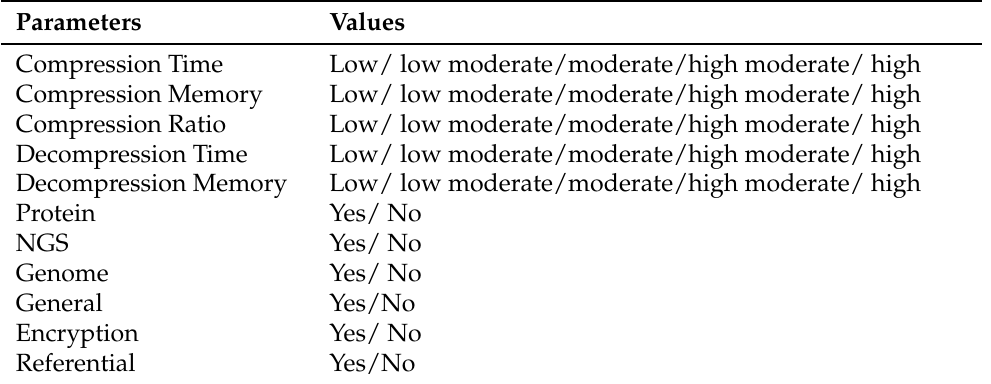
Figure 2. Structure of the knowledge base. Table 1. Values used for the selection of each parameter for all